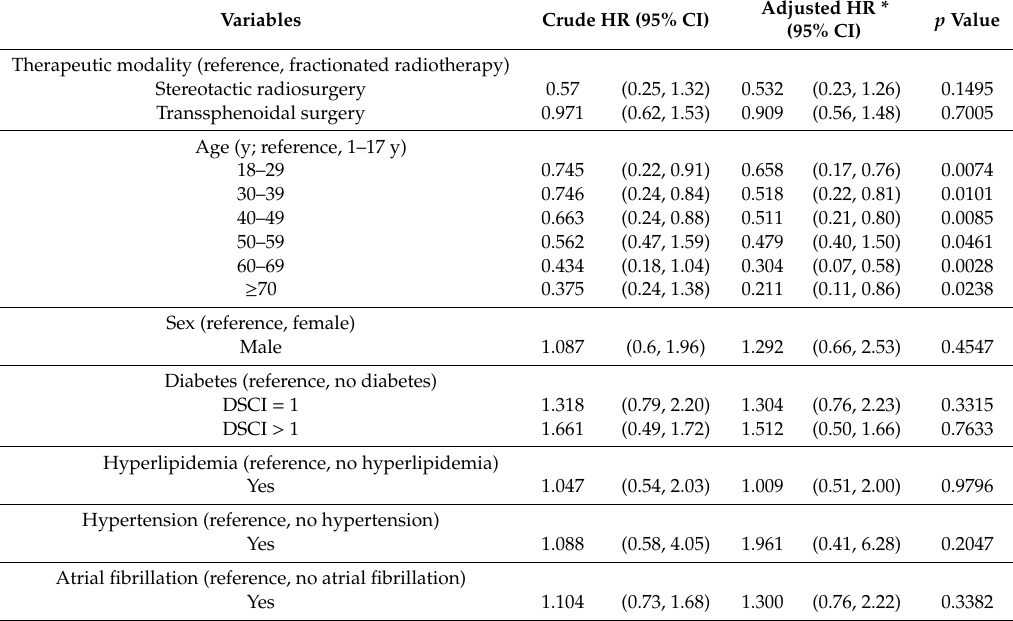
Table 5. Cox proportional hazards regression analysis of second primary brain or head and neck cancer risk in patients with nonfunctioning pituitary macroadenomas who received di ff erent treatments.